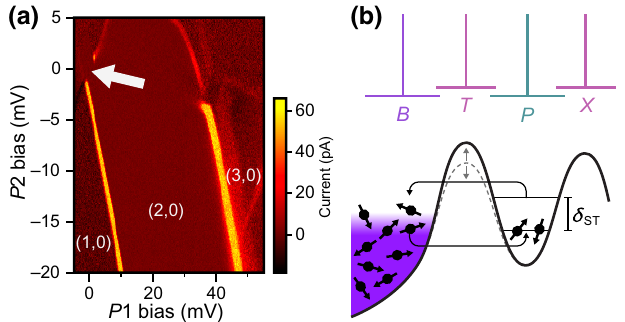
FIG. 5. A sweep of initialization bias and schematic of the ini- tialization process. (a) This signal (color) is the difference of spin measurements between preparations of an initialized state and of a dephased state. When initialization is effective, these measurement results are not identical. Sweeping the plunger-gate initialization bias of the P1 and P2 dots, we see two bands at the (1,0)-(2,0) and (2,0)-(3,0) charge-cell boundaries, which are both usable regions for initialization. The light gray arrow indicates the bias region used for S2C during measurement. (b) Near the (2,0)-(1,0) charge-state transition, the tunneling rate between the P1 dot and the 2DEG bath is greatly accelerated, leading to rapid thermalization and depopulation of the (2,0) excited states. The detuning span of this region is set by the 2 e singlet-triplet split- ting. The rate can be further increased by dynamically depressing the dot-bath barrier (dashed line), physically realized as the “T” gate visible in Fig.